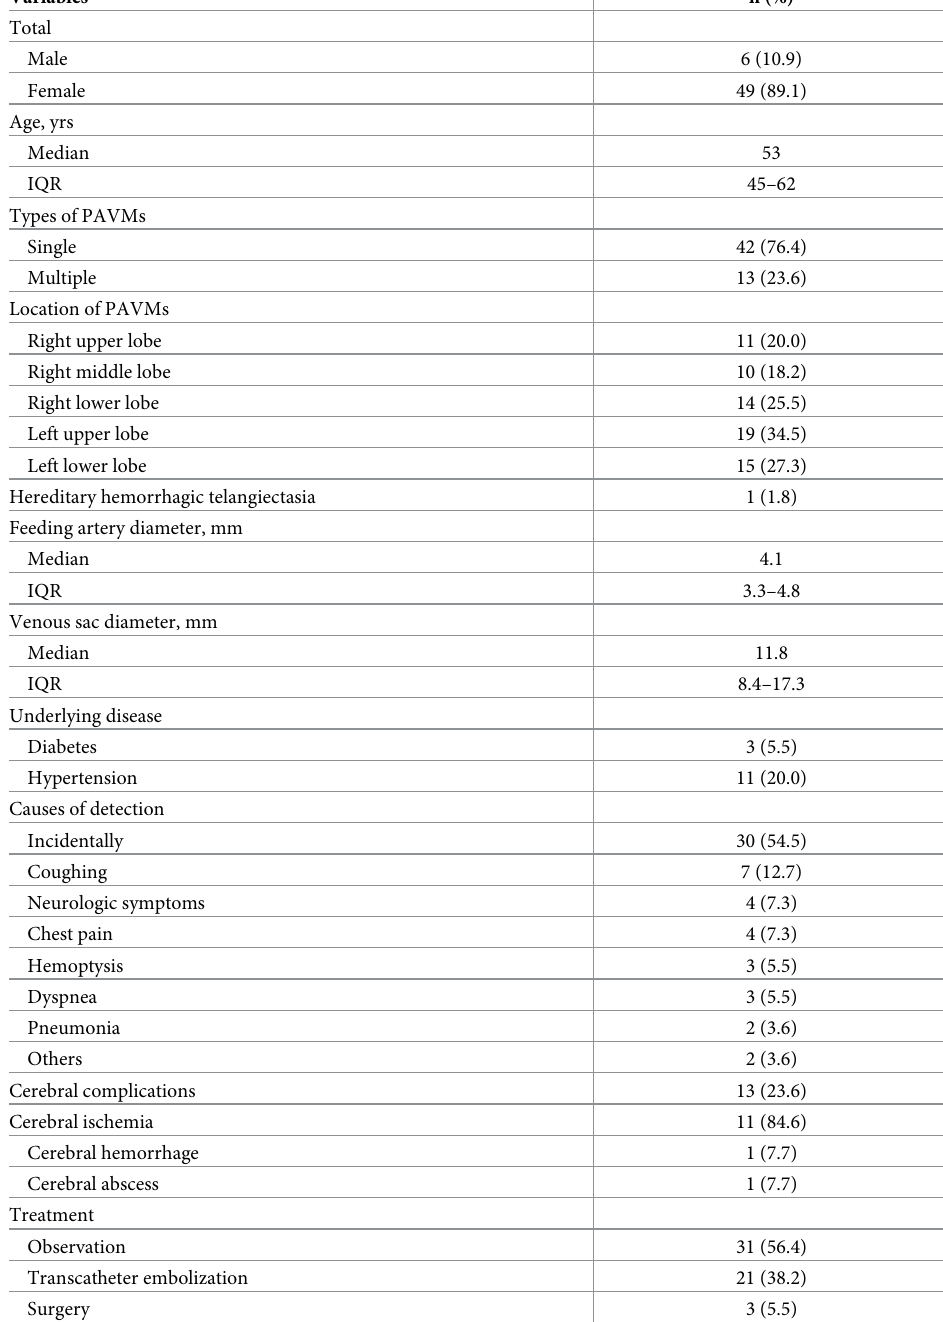
Table 1. Baseline characteristics of patients with pulmonary arteriovenous